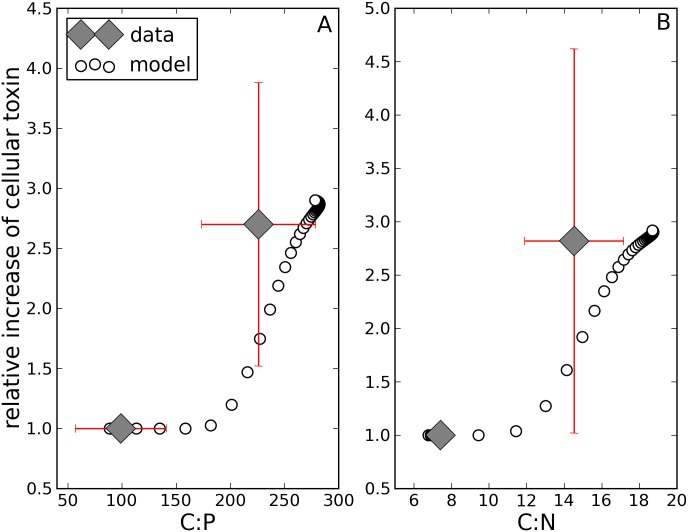
Simulated and observed changes in toxin content in response to C:P (A) and C:N (B) cellular ratios.Simulated toxin to carbon ratios have been normalized by the value of 0.001 (see Table 1 and Eq 1). Diamonds refer to the mean increase in cellular toxin observed in Karenia brevis grown under P-limited ([45], panel A) and N-limited ([44], panel B) conditions. The error bars represent the standard deviations.